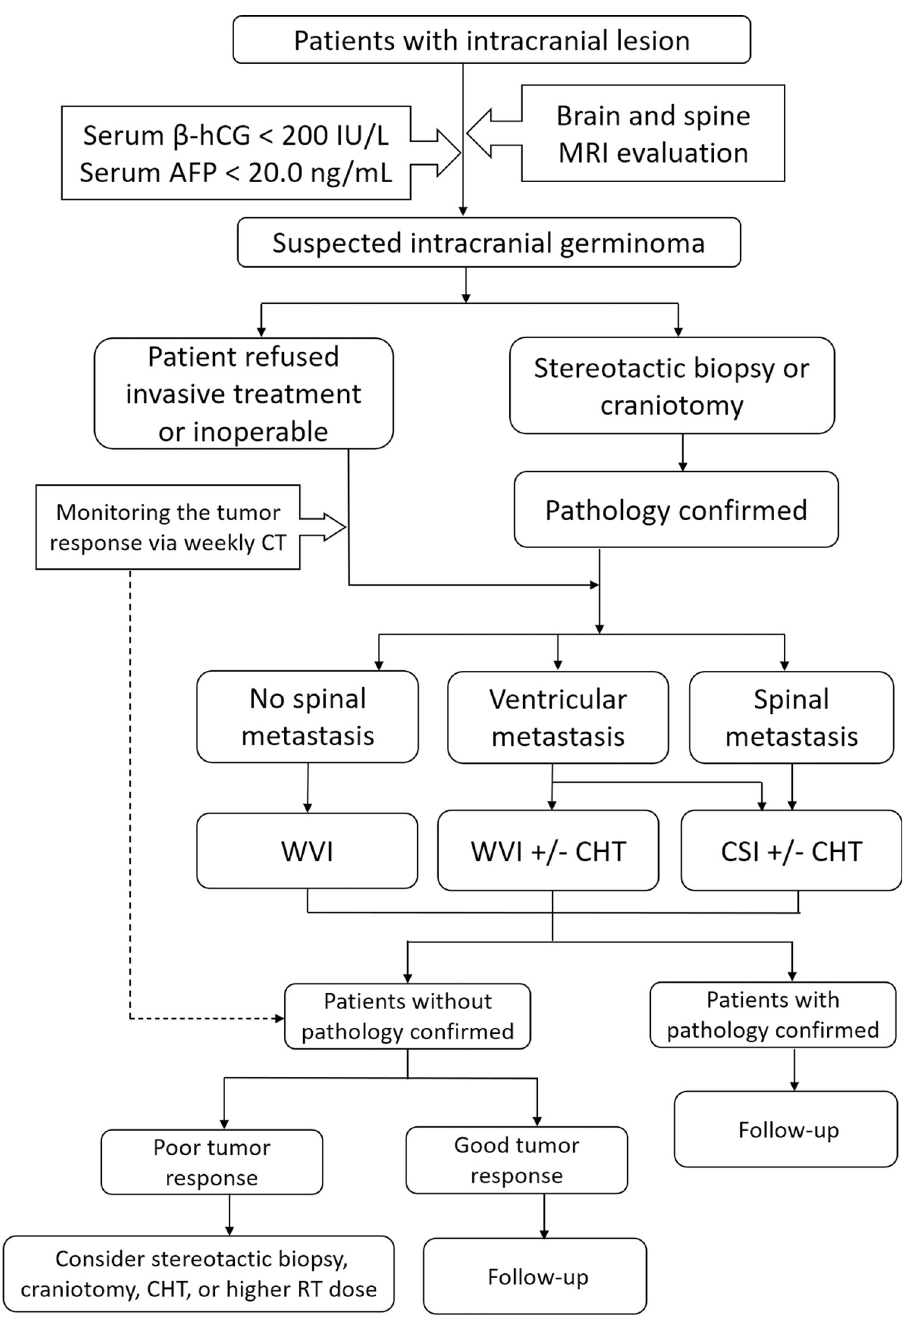
Fig 1. Treatment flow chart of intracranial germinoma